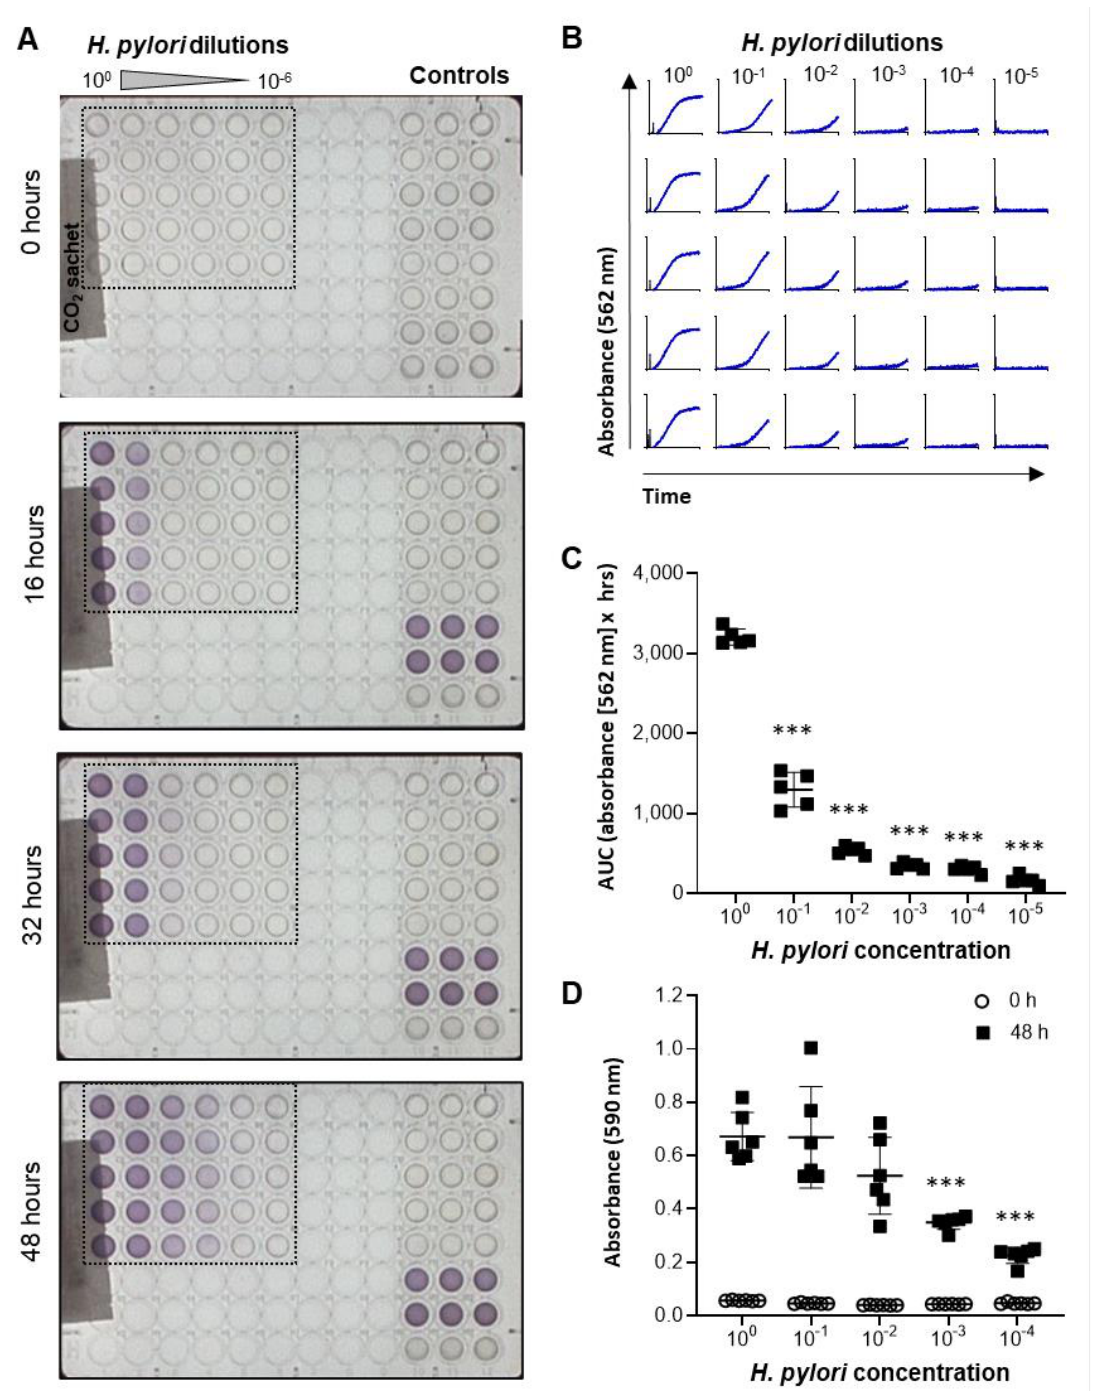
Figure 2. Development of a high-throughput metabolic assay to measure H. pylori growth. ( A ) Images of 96-well plates containing various concentrations of H. pylori (100 = stock solution used at OD600 = 0.5) obtained by the OmniLog ® incubator/reader at different time points after plating the bacteria. ( B ) Growth curves based on absorbance at 562 nm for the wells outlined in panel A. ( C ) Area under the curve was determined using GraphPad Prism and shows significant differences in H. pylori metabolism between cultures with different initial concentrations of bacteria. ( D ) Endpoint absorbance (48 h) of an H. pylori culture analyzed in a standard 96-well plate reader at 590 nm. Data are representative of n = 4 similar experiments with 5–6 technical replicates each. Individual datapoints, mean ± SD are shown. *** p < 0.01 compared to undiluted bacteria, one-way ANOVA with Dunnett’s multiple comparisons.